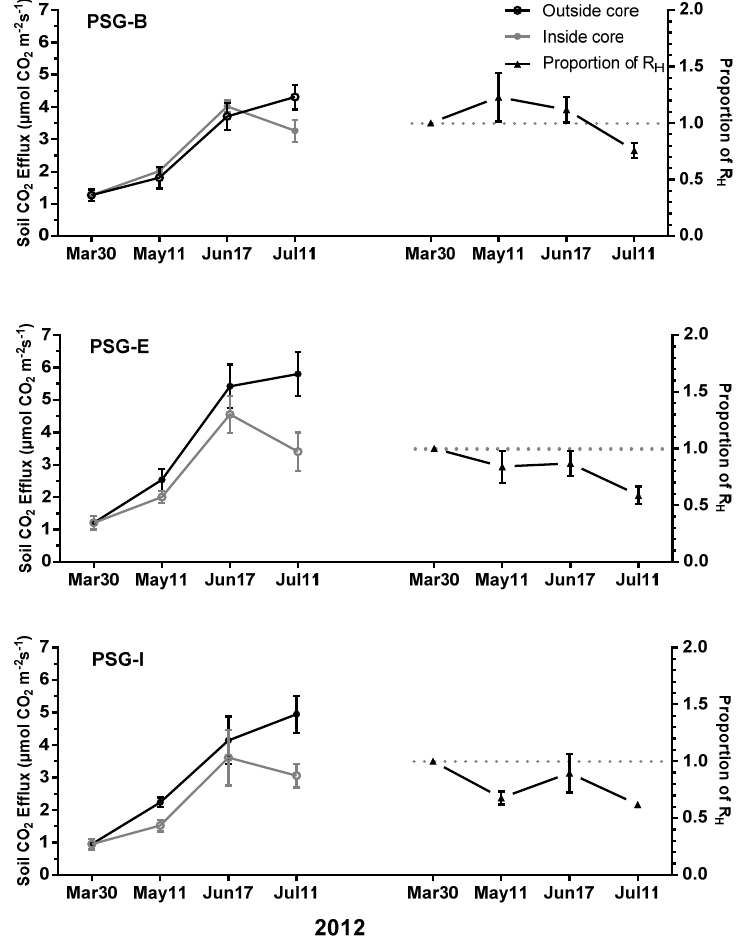
Figure 4. R S rates measured inside and outside cores and the proportion of R S attributed to R H (R S inside core/R S outside core) following installation of 35 cm root exclusion cores in a four ‐ year ‐ old switchgrass and loblolly pine agroforestry system on the lower coastal plain of North Carolina. Error bars represent ± 1 standard error of the mean. The PSG treatment represents pine intercropped with switchgrass. Additional treatment designations indicate the microtopographical position of the sample location where B = bedded row, I = interbed space, and E = edge where an aboveground transition from switchgrass to pine was observed.